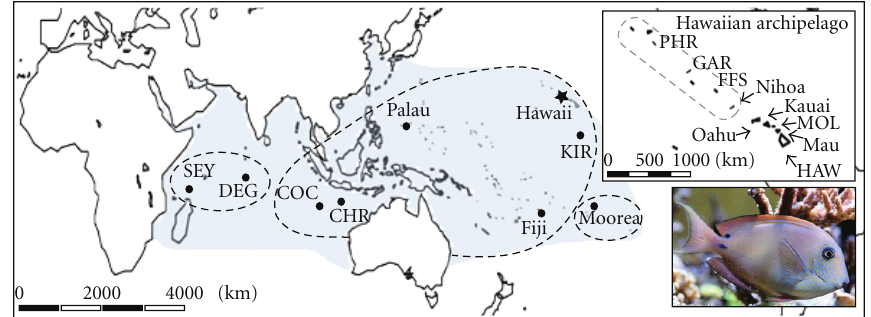
Figure 1: Location of Brown Surgeonfish ( Acanthurus nigrofuscus ) collection sites. Collections in Hawaii were made in June/July 2005-06, and elsewhere from September 2006 to June 2009. Inset details collections within the Hawaiian Archipelago, with the boundary of the Papah¯anaumoku¯akea Marine National Monument indicated by the dashed circle. Site abbreviations are as follows: SEY, Seychelles; DEG, Diego Garcia; COC, Cocos Islands; CHR, Christmas Island; KIR, Kiritimati; PHR, Pearl and Hermes Reef; GAR, Gardner Pinnacles; FFS, French Frigate Shoals; MOL, Molokai; HAW, Hawaii Island. Dashed borders on the main map indicate site groupings as determined in Samova . Photo credit: